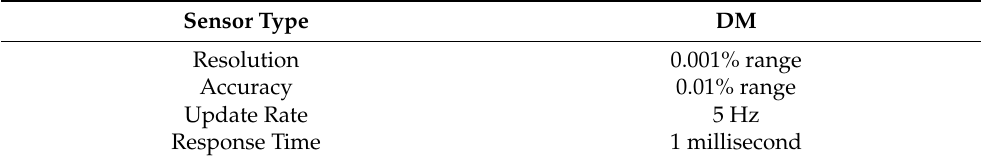
Table 4. Specification of DM used on the AUV